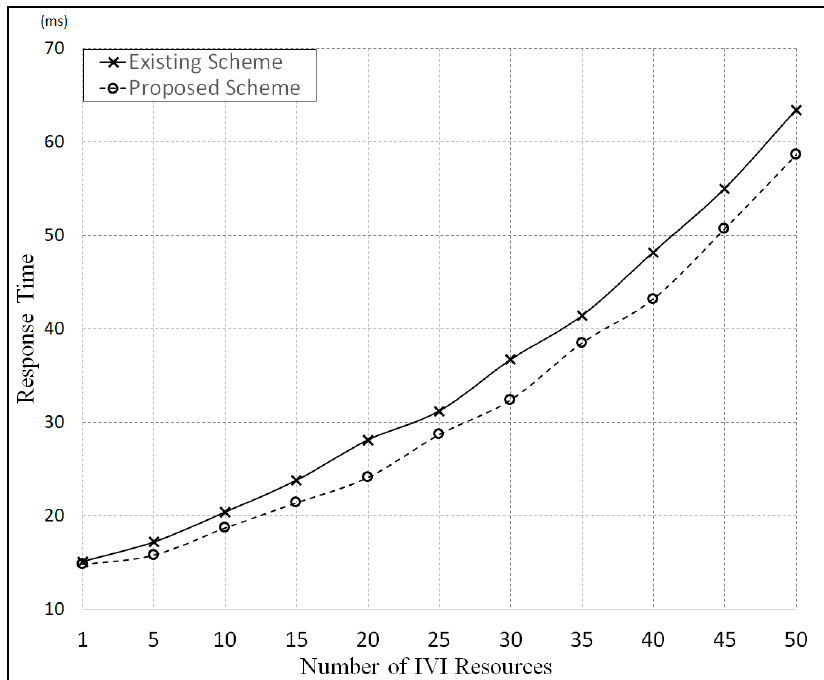
Figure 22. Comparison of response times for IVI resource control messages.